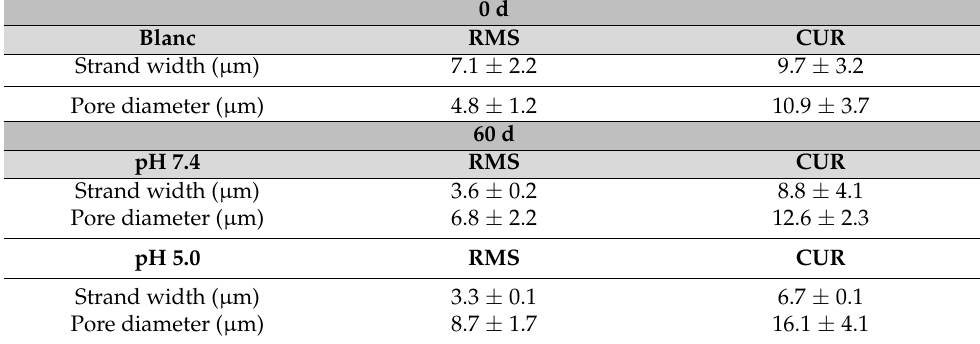
Table 4. Strand width and pore diameter of the different